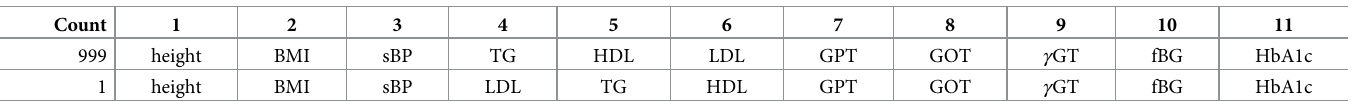
Table 5. Frequencies of orders of various indices in 1000 trials for women in their 70s estimated from ICA-LiNGAM.